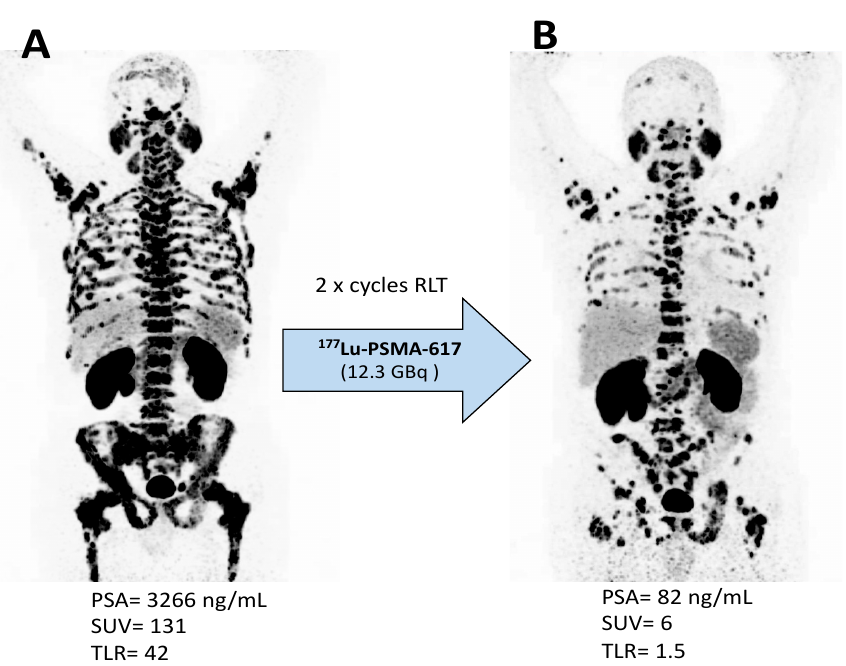
Figure 3. Waterfall plots illustrating the relative changes in standard biochemical parameters (PSA) after two cycles of 177 Lu-PSMA-617 RLT compared to the assessment in molecular-imaging based response with TLR ( A ) and SUV ( B ). Values marked with * highlight the discordant cases.